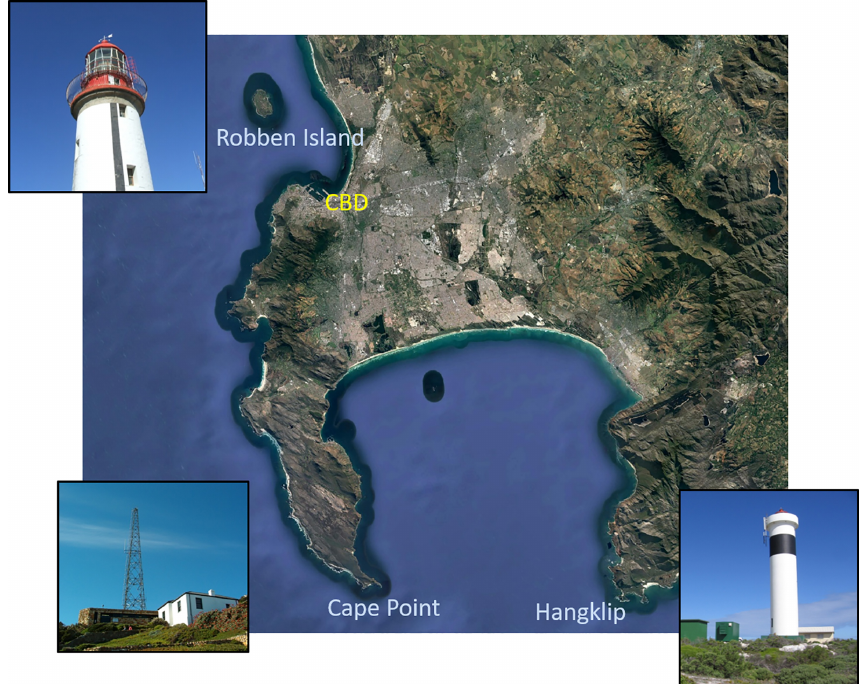
Figure 1. Google Earth image of the domain, where Cape Town is located at the centre. The corner coordinates of the full domain are 33 ◦ 29 (cid:48) 42 . 00 (cid:48)(cid:48) S 18 ◦ 11 (cid:48) 42 . 00 (cid:48)(cid:48) E (top left), 33 ◦ 29 (cid:48) 42 . 00 (cid:48)(cid:48) S; 19 ◦ 12 (cid:48) 18 . 00 (cid:48)(cid:48) E (top right); 34 ◦ 30 (cid:48) 18 . 00 (cid:48)(cid:48) S, 18 ◦ 11 (cid:48) 42 . 00 (cid:48)(cid:48) E (bottom left); and 34 ◦ 30 (cid:48) 18 . 00 (cid:48)(cid:48) S, 19 ◦ 12 (cid:48) 18 . 00 (cid:48)(cid:48) E (bottom left). The locations of the measurement sites and the Cape Point GAW station background site are indicated together with images of these sites (photo credits: Ernst Brunke and Alecia Nickless). CBD is the central business